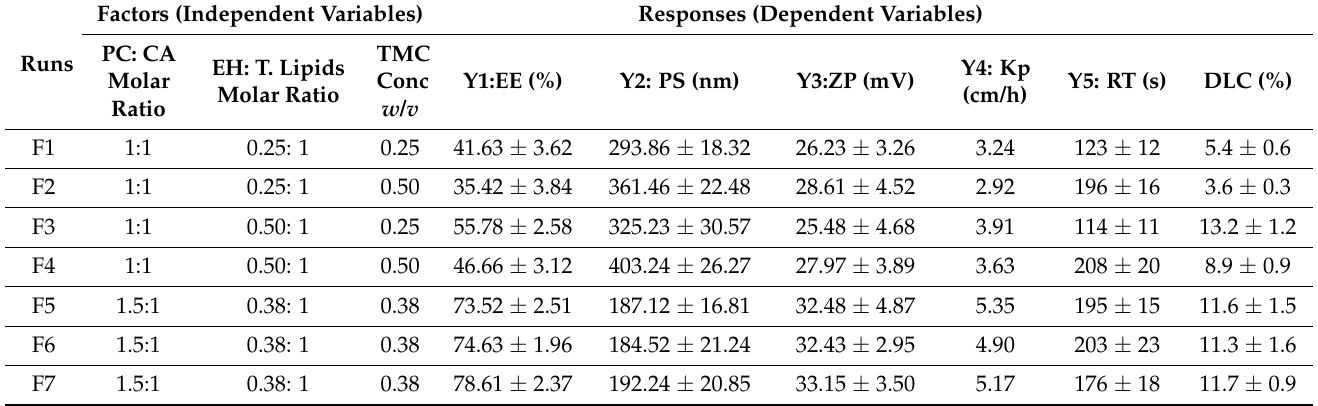
Table 2. Experimental runs, independent and dependent variables of the 2 3 full factorial experimental designs of EH-loaded